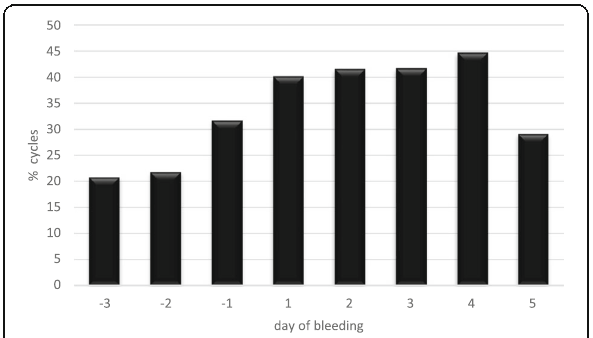
Fig. 4 Migraine attacks in combined hormonal contraceptive users in relation to start of bleeding during days − 3 to day 5